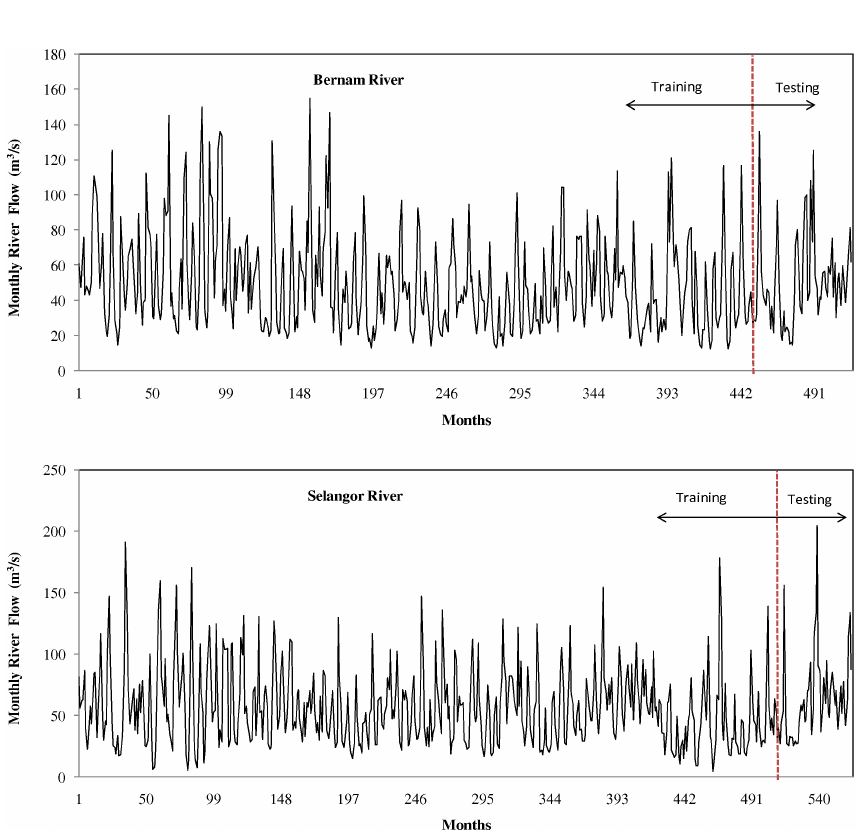
Fig. 6. Time series of monthly river flow of Selangor and Bernam